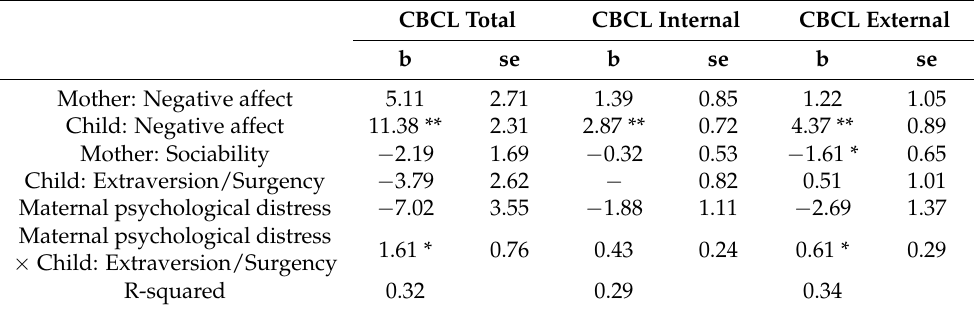
Table 7. The multivariate associations of child and maternal temperamental characteristics and maternal distress with child problem